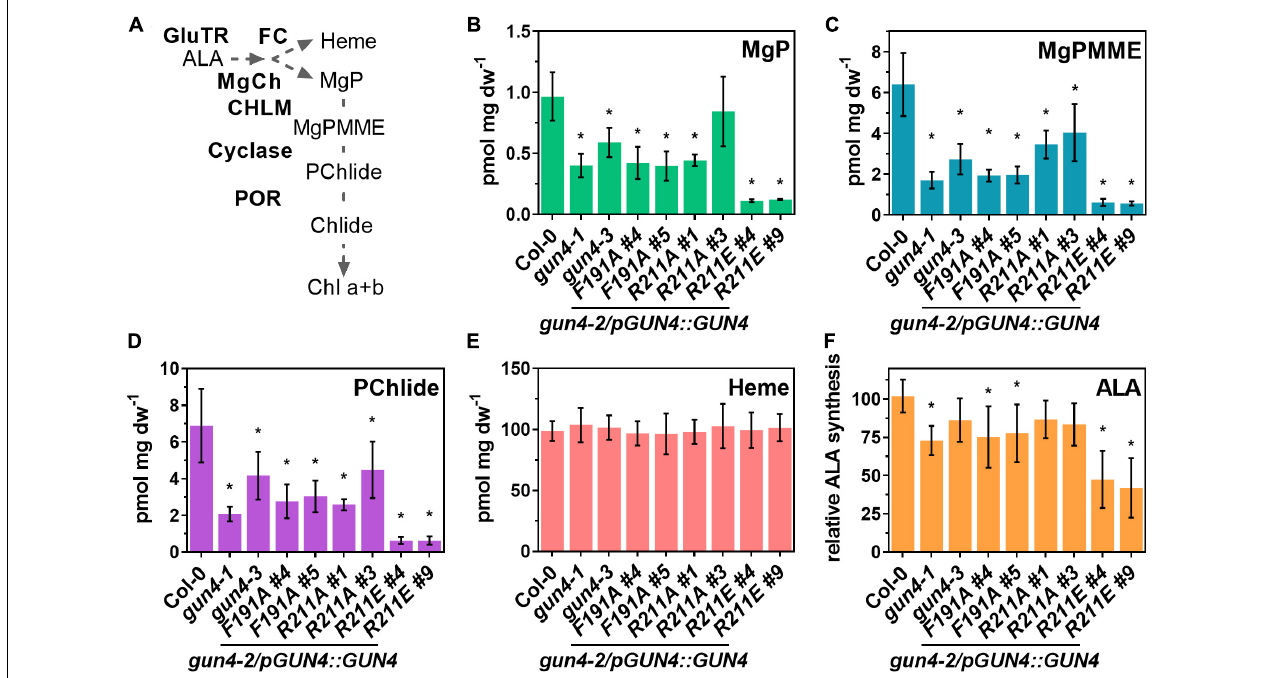
FIGURE 3 | Analysis of porphyrin steady-state level, heme content and ALA synthesis capacity in gun4-2 complementation lines expressing GUN4 ( F191A ), GUN4 ( R211A ), and GUN4 ( R211E ). (A) Schematic presentation of the tetrapyrrole biosynthesis, including the intermediates within the Chl branch and the involved enzymes. Abbreviations are given in the main text. Steady state level of (B) Mg-protoporphyin IX (MgP), (C) Mg protoporphyin IX monomethylester (MgPMME), (D) Protochlodophyllide (PChlide), (E) heme, and (F) ALA synthesis capacity (relative to the WT control) in leaves of 21 days old plants grown in short-day (SD). Statistical significance relative to the WT (* p < 0.05) was calculated using one-way ANOVA and Dunnett’s multiple comparison test with n ≥ 7 ( B–E , except R211A#1, n = 4) and n ≥ 7 (D–F) replicates from two independent experiments. Values are given as the mean ±